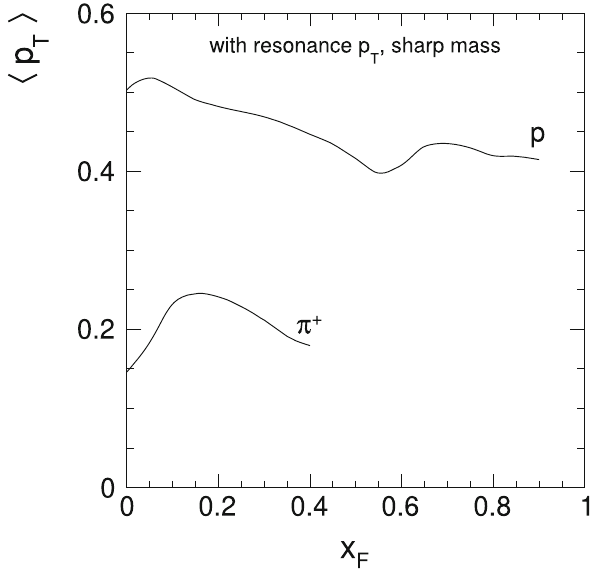
Fig. 153 Mean p T for decay protons and pions as a function of x F